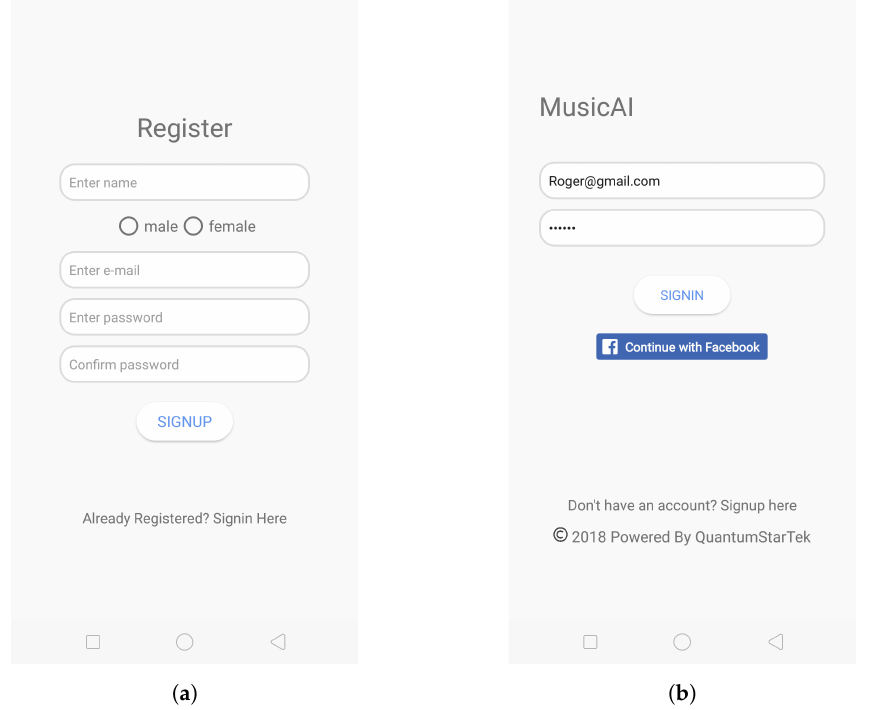
Figure 4. ( a ) registration form a user to get the user details; ( b ) user’s login